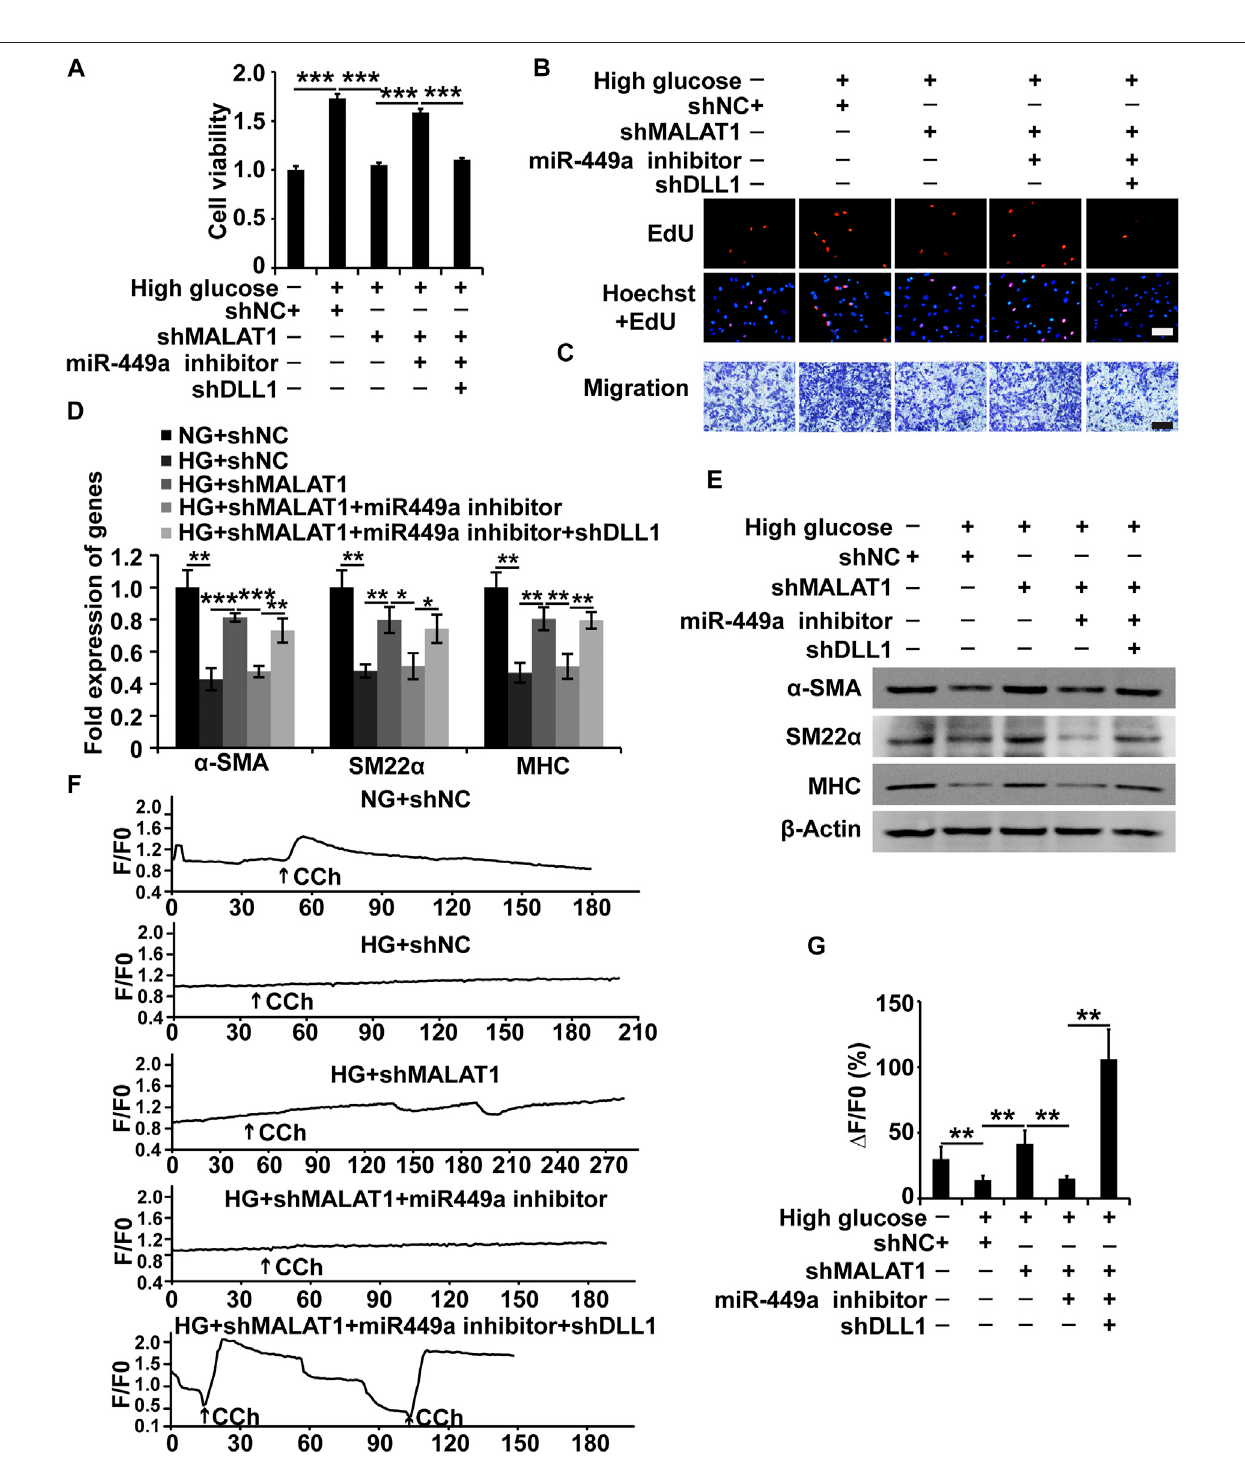
FIGURE 6 | The MALAT1/miR-499a/DLL1 pathway regulates the cellular processes, phenotypic switch and CCh-induced Ca2+ transient signals in HGSMCs under HG conditions. (A – C) CCK8, EdU, and Transwell assays for the analysis of the viability, proliferation, and migration of HGSMCs under different treatments. (D – E) qPCRandwesternblotanalysesofSMCcontractilemarkers( α -SMA,SM22 α ,andMHC)inHGSMCsunderdifferenttreatments. (F) CCh(100 μ mol/L) — induced[Ca 2+ ] i changesinHGSMCsunderdifferenttreatments.ChangesinCa 2+ fl uorescenceintensityareexpressedasF/F0,whereF0isthebasal fl uorescenceintensitybefore stimulation. (G) Histogram analysis of the [Ca 2+ ] i changes, where Δ F is the fl uorescent intensity of the response minus F0. For (A – G) , fi ve groups were analyzed: NG + shNC group, HG + shNC group, HG + shMALAT1 group, HG + shMALAT1+miR-449a inhibitor, HG + shMALAT1+miR-449a inhibitor + shDLL1 group. β -Actin was used as an internal control. *** p < 0.001, ** p < 0.01, * p < 0.05.